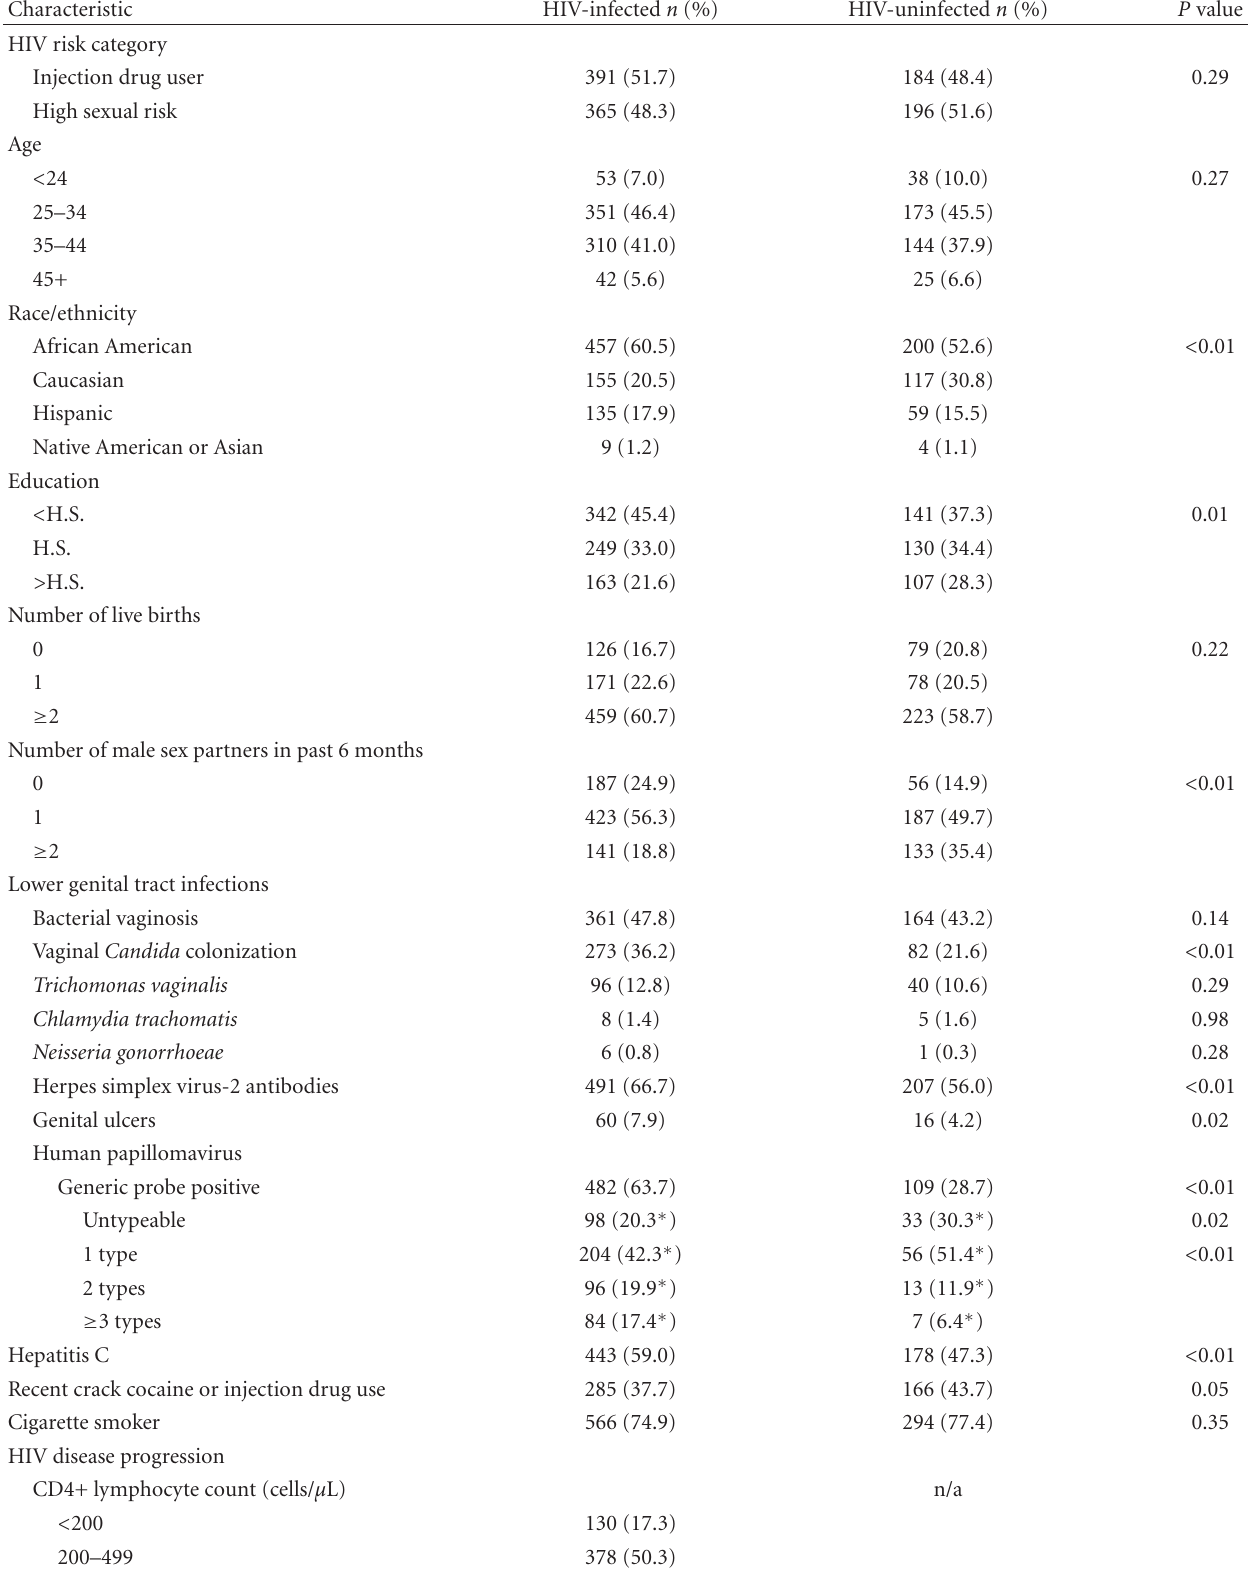
Table 1: Characteristics of 756 HIV-infected and 380 HIV-uninfected women at enrollment to HERS.